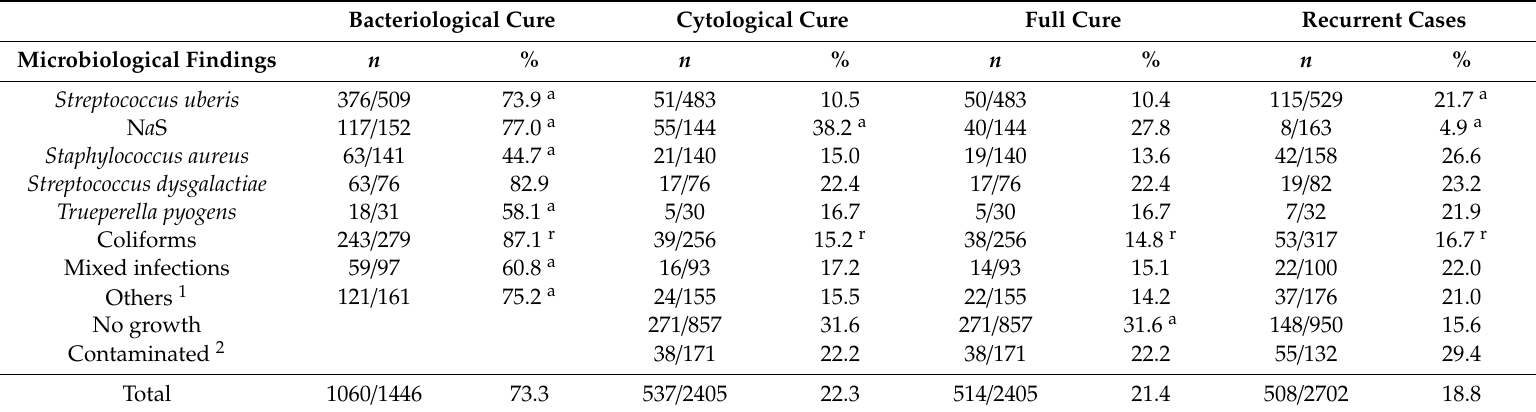
Table 6. Outcomes by microbiological findings of clinical mastitis cases ( n = 2883) in Northern Germany. Bacteriological Cure Cytological Cure Full Cure Recurrent